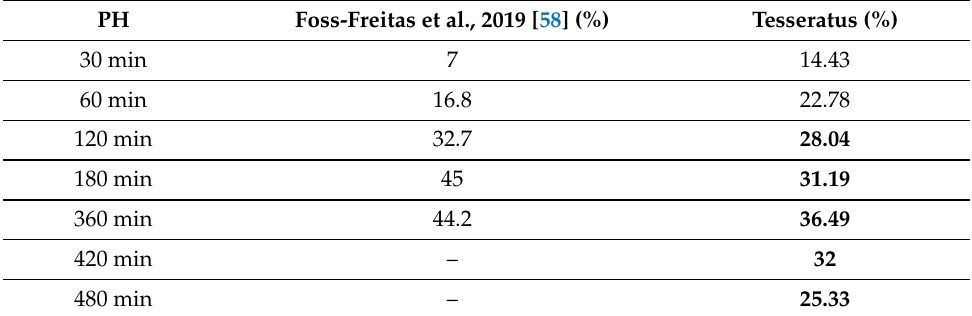
Table 11. MAPE at nighttime comparison between Foss-Freitas et al., 2019 [58] and Tesseratus— 21 days of training. PH Foss-Freitas et al., 2019 [58] (%) Tesseratus